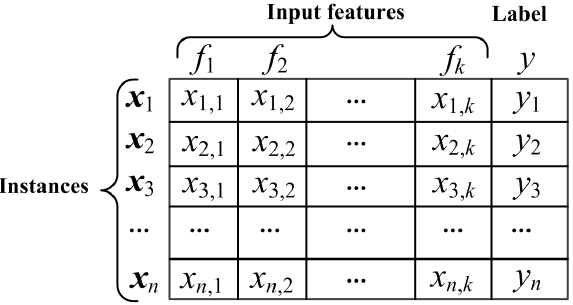
Figure 1. Dataset for machine learning ‐ based transient stability prediction.